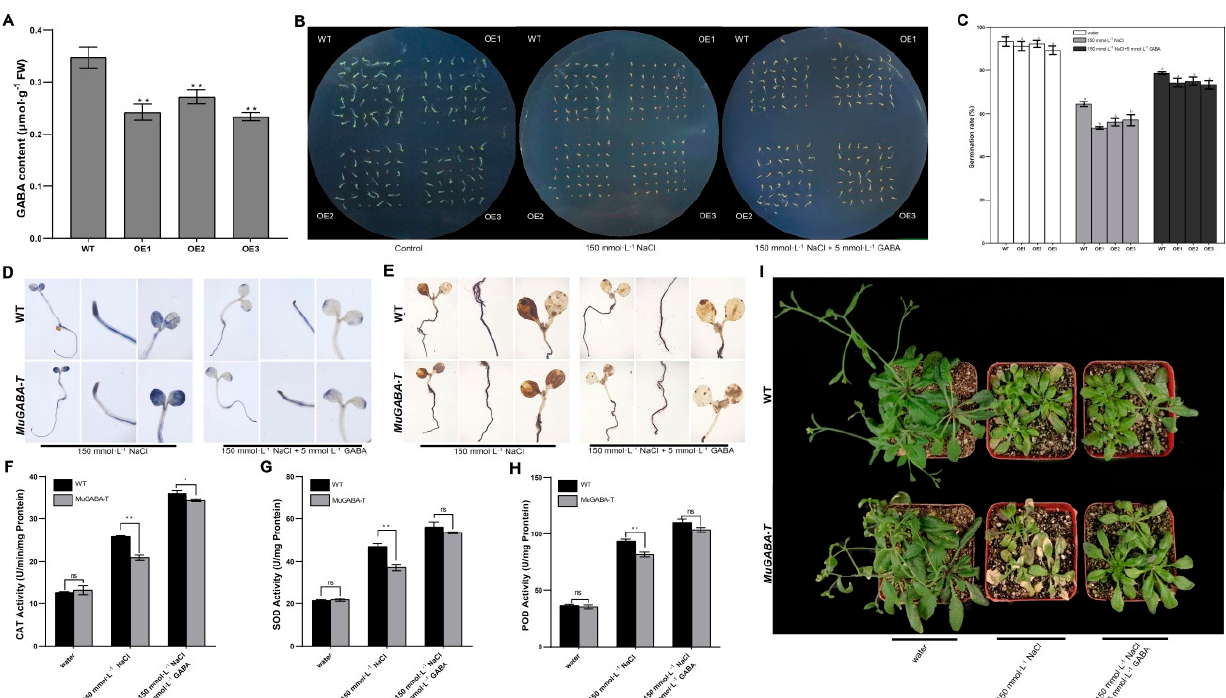
Figure 6. Exogenous application of GABA alleviates the sensitivity of transgenic MuGABA-T Ara- bidopsis to salt stress. ( A ) GABA content in transgenic MuGABA-T and WT Arabidopsis seedlings. The double asterisks indicate significant differences at p < 0.05. ( B , C ) Germination of WT and trans- genic MuGABA-T Arabidopsis upon NaCl treatment with or without GABA. Seeds were grown in Petri dishes for 7 d in 1/2 MS medium upon 0 or 150 mmol · L − 1 NaCl treatment with or without 5 mmol · L − 1 GABA. Data are mean ± SD, and the different letters above the columns indicate signifi- cant difference ( p < 0.05) according to Duncan’s multiple range test. Accumulation of superoxide ( D ) and H 2 O 2 ( E ) in the Arabidopsis seedlings upon NaCl treatment with or without GABA. The purple-blue staining indicates formazan deposits produced by superoxide anion reacting with NBT and the brown coloration indicates the polymerization product formed by H 2 O 2 reacting with DAB. Activities of superoxide dismutase (SOD) ( F ), peroxidase (POD) ( G ) and catalase (CAT) ( H ) in the seedlings upon NaCl treatment with or without GABA. The seedlings were collected at 7 d after treatment. Values are the means ± SD, and the double asterisks indicate significant differences at p < 0.05. ( I ) Morphology of Arabidopsis seedlings upon NaCl treatment with or without GABA. The 4-week-old seedlings were grown in pots under control conditions, followed by 150 mmol · L − 1 NaCl treatment. At the same time, 50 mmol · L − 1 GABA solution was sprayed on the leaves for 7 consecutive days, and the seedlings sprayed with water were used as